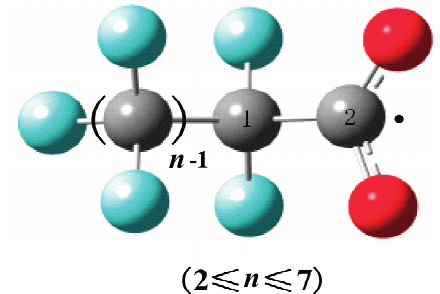
Figure 3. The atom number of PFCAs (2 ≤ n ≤ 7)